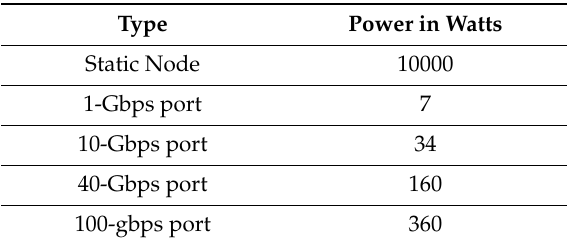
Table 2. Power consumption values for node and